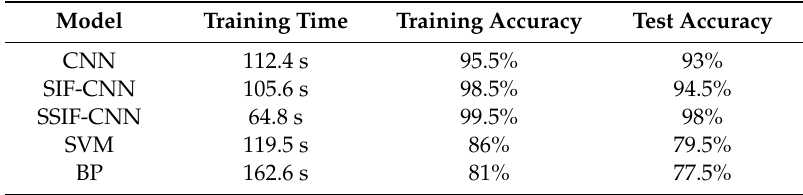
Table 14. Training time and accuracy of each